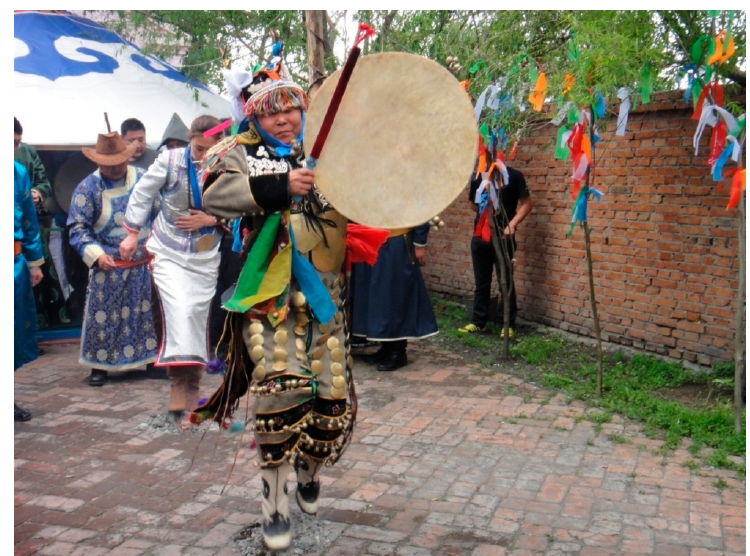
Figure A1. Wo Jufen Shaman leads the candidates to step on and cross the fire to purify their bodies (On 14 June 2013, Lina’s initiation ritual as jad’ ə n and bar ʃ ). Photo: Minna Sa, 2013.